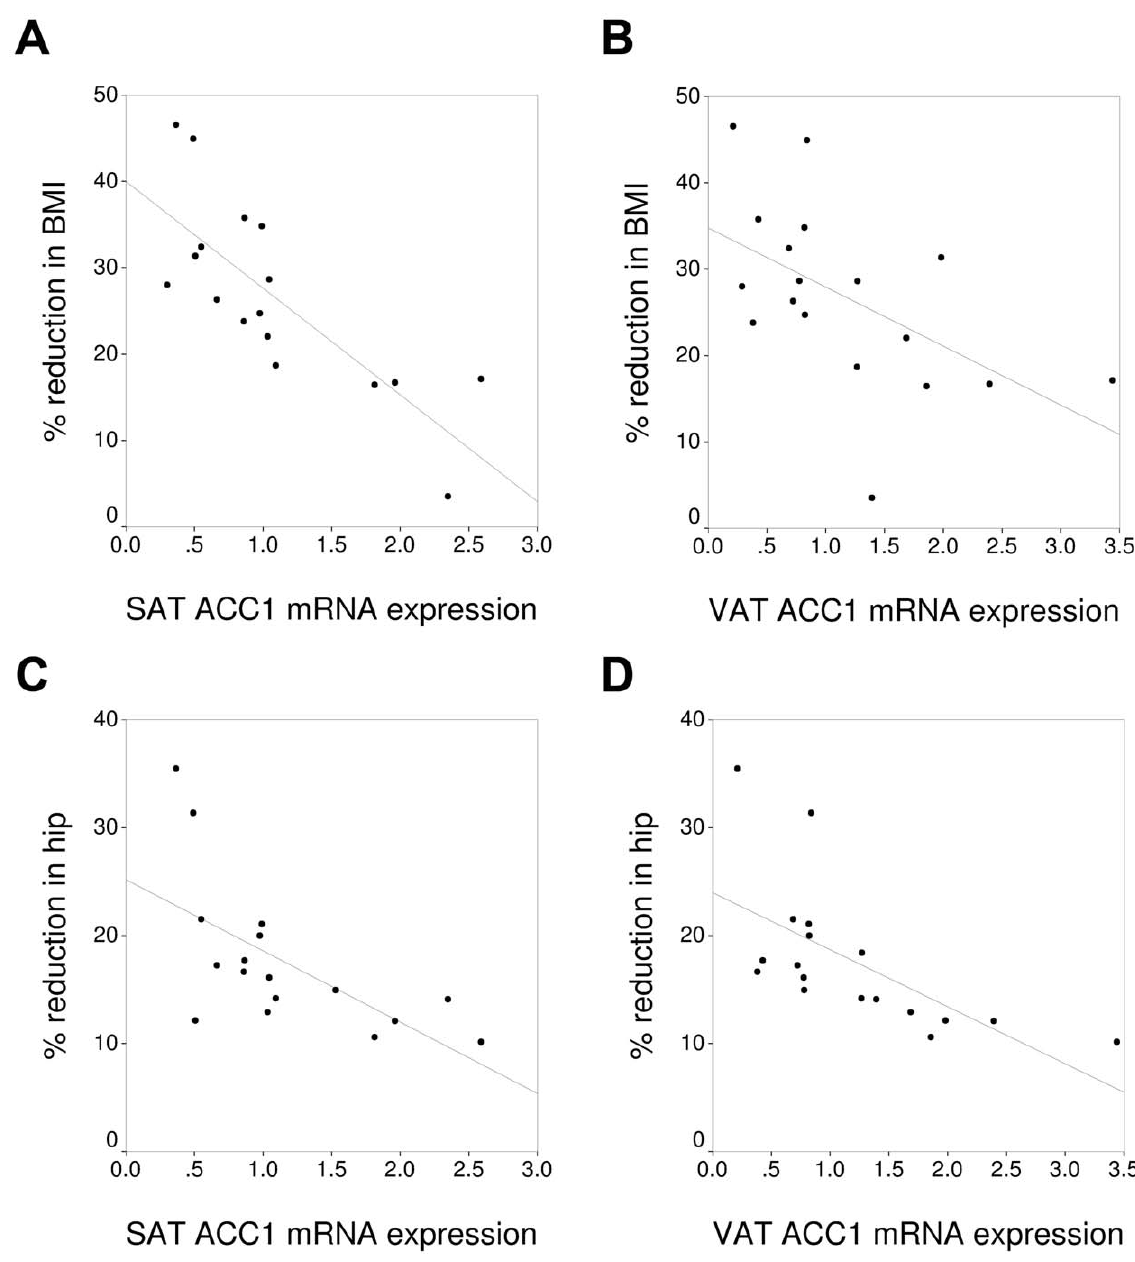
Figure 2. Association between the expression of acetyl-CoA carboxylase 1 (ACC1) and the percentage of reduction in the body mass index (BMI) in subcutaneous (A) and visceral adipose tissue (B), and the hip circumference in SAT (C) and VAT (D). BMI: body mass index.